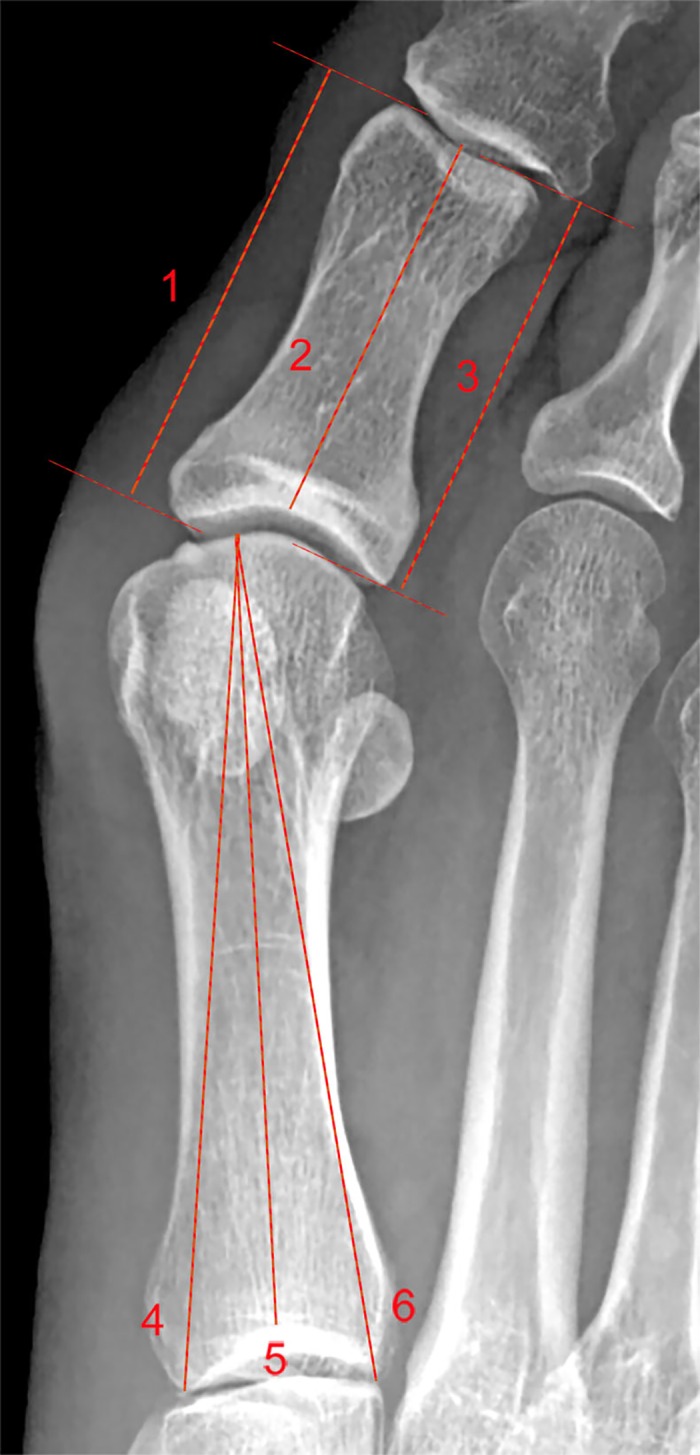
On the weight-bearing dorsoplantar foot radiograph, lines were measured and drawn; line 1 is the longitudinal distance medial aspect of the proximal phalanx (LDMPPH); line 2 is the longitudinal distance central aspect of the proximal phalanx (LDCPPH); line 3 is the longitudinal distance lateral aspect of the proximal phalanx (LDLPPH); line 4 is the longitudinal distance medial aspect of the I metatarsal bone (LDM-M); line 5 is the longitudinal distance central aspect of the I metatarsal bone (LDC-M); line 6 is the longitudinal distance lateral aspect of the I metatarsal bone (LDL-M).